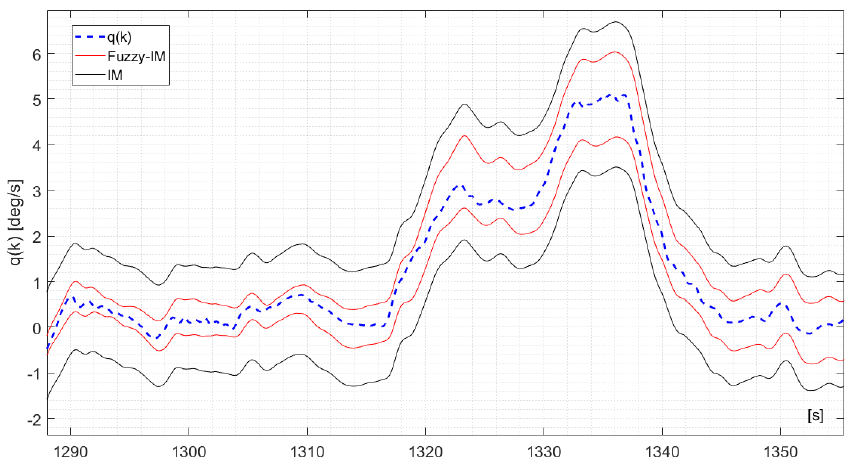
Figure 5. The measured q ( k ) signal and the time varying upper bounds q ( k ) and lower bounds q ( k ) derived for the IM applying Equation (18) and for the FIM applying Equation (20). Sensors 2018 , 18 , x FOR PEER REVIEW 14 of 22